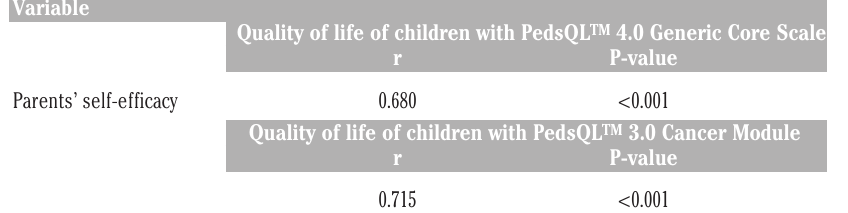
Table 3. Relationship between parents’ self-efficacy and quality of life of children with PedsQL TM 4.0 Generic Core Scale and PedsQL TM 3.0 Cancer Module Aged 8-12 years